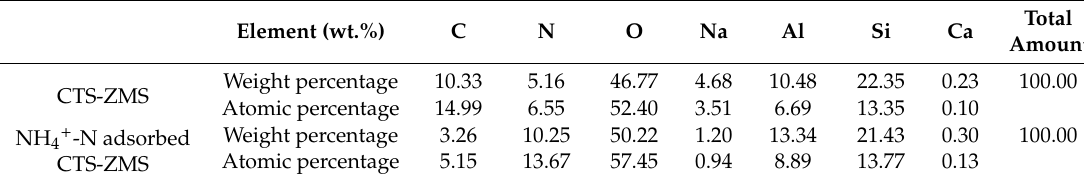
Table 4. Element percentage of CTS-ZMS before and after ammonium nitrogen adsorption in fixed-bed column.